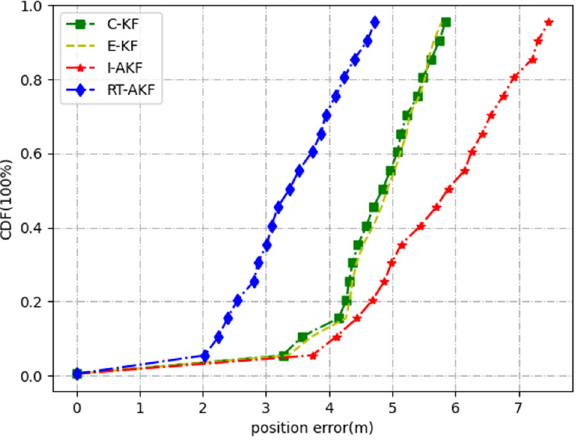
Figure 17. Accuracy comparison by different methods in segment #6.